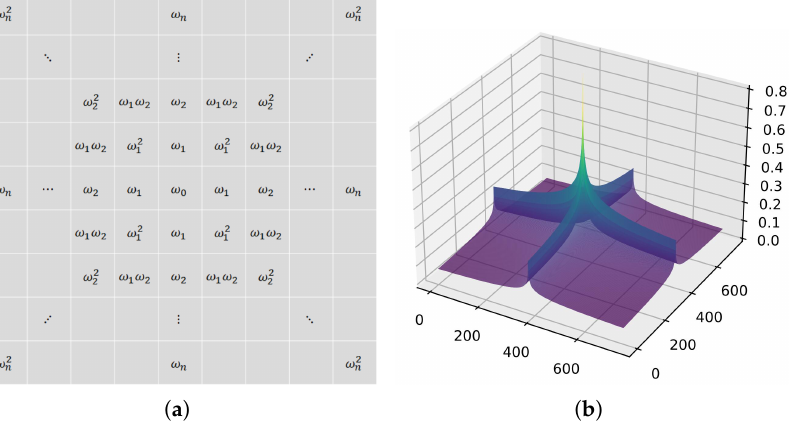
Figure 4. FDIF kernel based on the fractional double integral. ( a ): Coefficients in the kernel; ( b ): Visualized version of the kernel by Matplotlib [19]. Unlike in the 8-direction operator, all of the coefficients in the kernel are unequal to zero as long as 1 − α (cid:54) = j . Since we assume α > 0 and ( α ) = 1, the coefficients are all nonzero. In particular, the coefficients all become one when the ω 0 fractional order α equals 1, and the filter becomes an average filter. Coincidentally, some of the Retinex implementations use average filtering in practice to estimate the light to lower computational